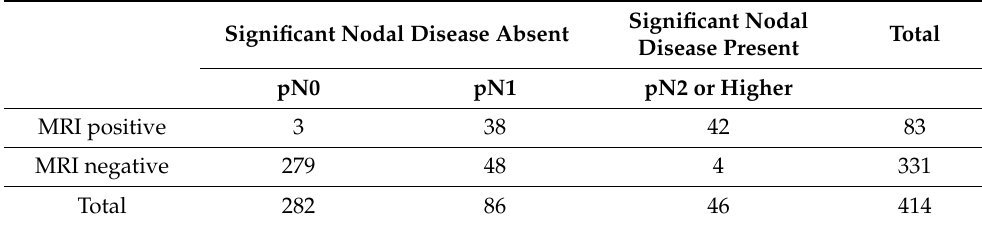
Table 2. Cross-tabulation of MR findings and N-stage.